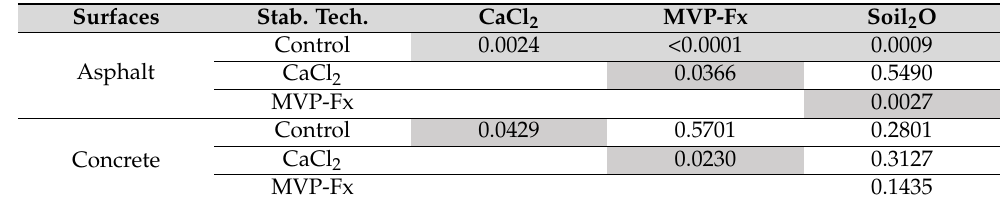
Figure 13. Percent Removal of Sr-85 Contaminated Particles for Straight-line Walking Experiments. Table 8. Statistical results ( p -values) for foot traffic experiment percent removal. Gray shading indicates a significant difference ( p <